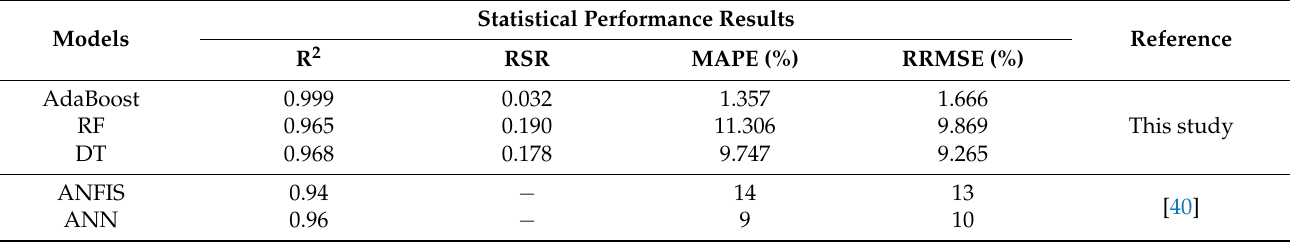
Table 4. Comparison of statistical results obtained from the applied predictive models using training phase with available ANFIS and ANN models.